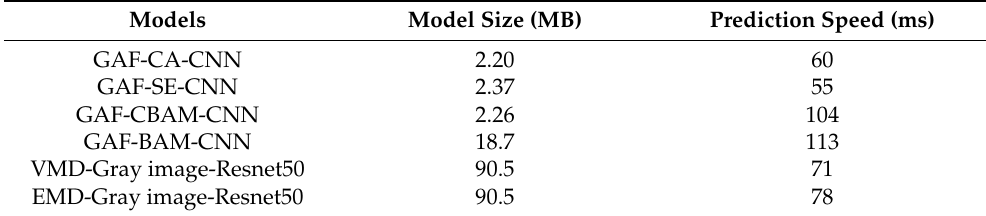
Table 4. Parameter size and prediction speed of different models.